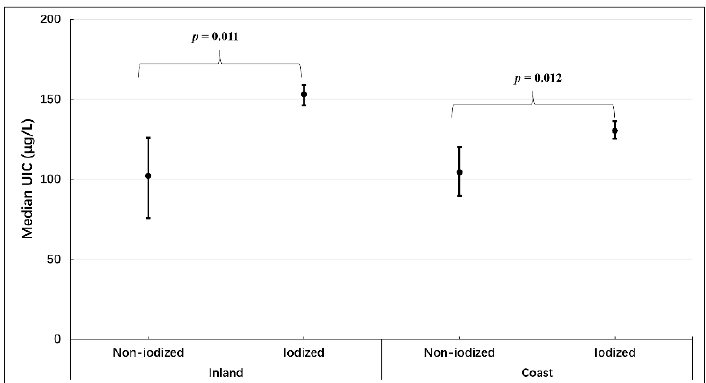
Figure 3. Urinary iodine status among participants according to region and type of salt consumed.